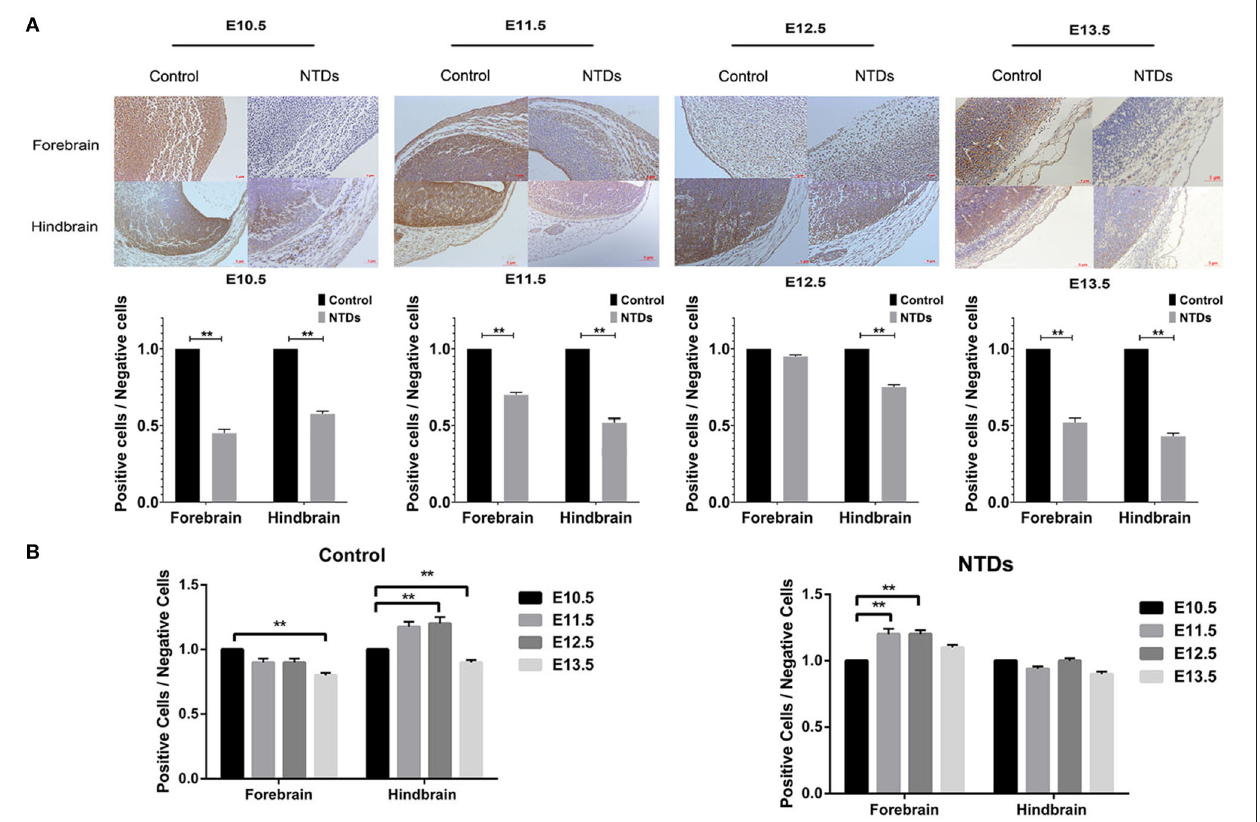
FIGURE 2 | Immunohistochemistry of the protein levels of Inpp5e expression in control and NTDs embryonic brain tissues at E 10.5, E 11.5, E 12.5, and E 13.5. (A) Immunohistochemistry of the protein expression of Inpp5e in embryonic brain tissues from E 10.5 to E 13.5, in forebrain, hindbrain respectively. ** P < 0.01 NTDs group ( n = 6) vs. control group ( n = 6). (B) The dynamic changes of Inpp5e expression patterns in embryonic murine brain tissues during E10.5–13.5, in forebrain, hindbrain respectively. ** P < 0.01 vs. E 10.5. Each experiment was carried out in triplicate.